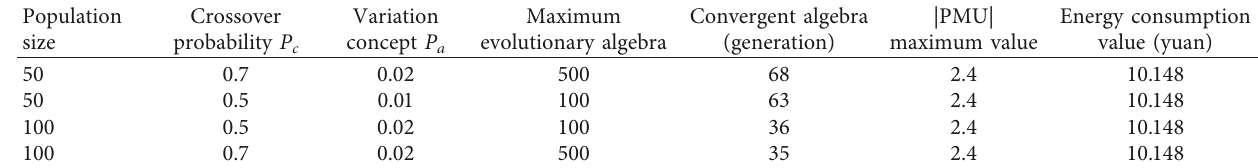
Table 2: Parameter Settings and effects when m � 1 and n � 1.